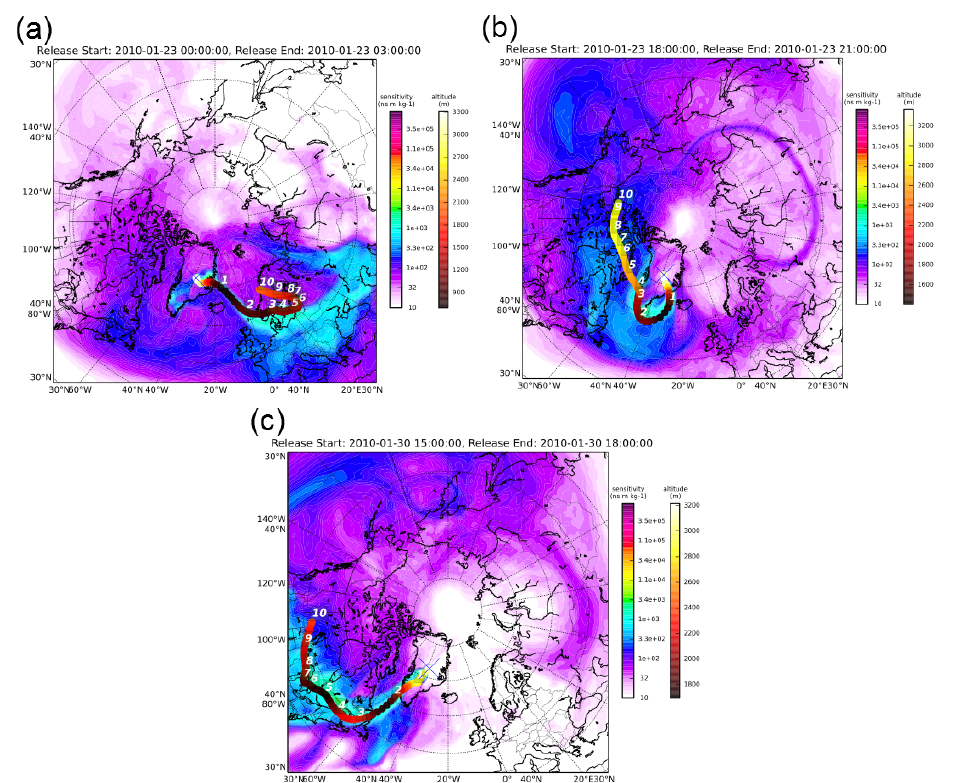
Figure 8. Simulated total column sensitivity (nsmkg − 1 ) for retroplumes originating at Summit on (a) 23 January 2010, at 00:00UTC, (b) 23 January 2010, at 18:00UTC, and (c) 30 January 2010, at 15:00UTC. The altitude circles represent the centroid location of the particles in the model domain N days back from the measurement date, where N is the number shown next to the shaded circles (up to 10 days are shown on the plots). The shading represents the altitude at three hourly intervals of the centroid location, given by the heat scale colourbar (note the change in scale for the